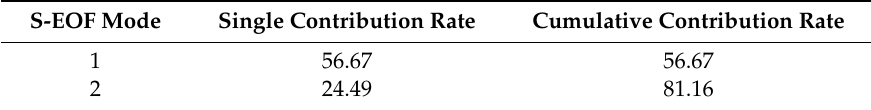
Table 4. Variance of the first three season-reliant empirical orthogonal function (S-EOF).